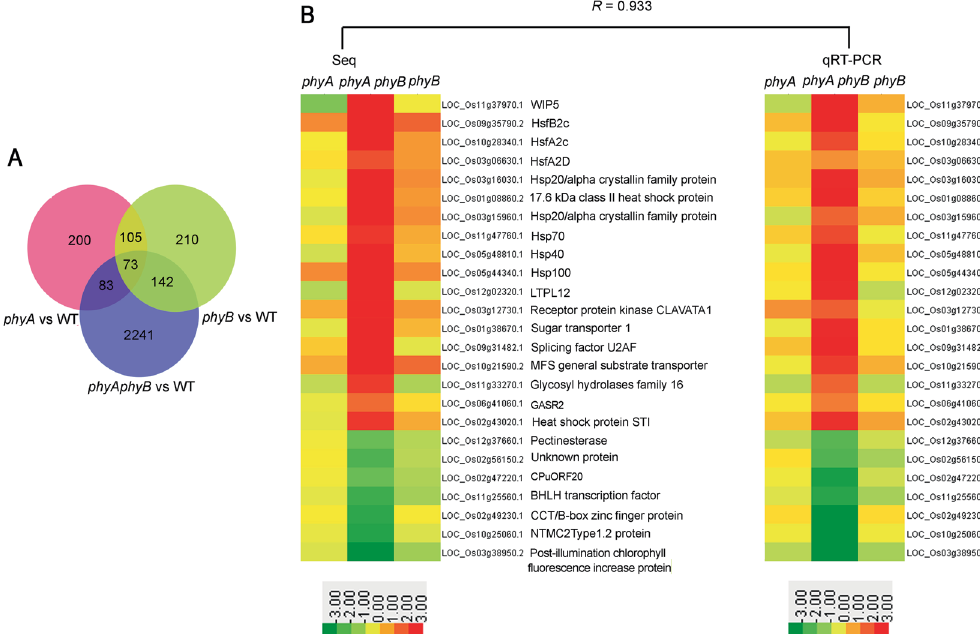
Figure 5. Comparison and validation of transcript profiles of anthers in phyA and phyB single and double mutants, and wild-type (WT) rice. ( A ) Distribution of differentially expressed genes in anthers among phyA and phyB single and double mutants, and WT. ( B ) Validation of RNA sequencing results by quantitative reverse transcription PCR. Transcript abundances represented by the two heat maps are the log2-transformed averages of RPKM values of the RNA sequencing analysis (left) from three biological replicates and transcript abundance values from three independent quantitative reverse transcription PCR experiments (right). The heat maps were drawn using Cluster 3.0. Relative expressions are indicated by the color scales at the bottom of the figure. R is the correlation coefficient value between the two